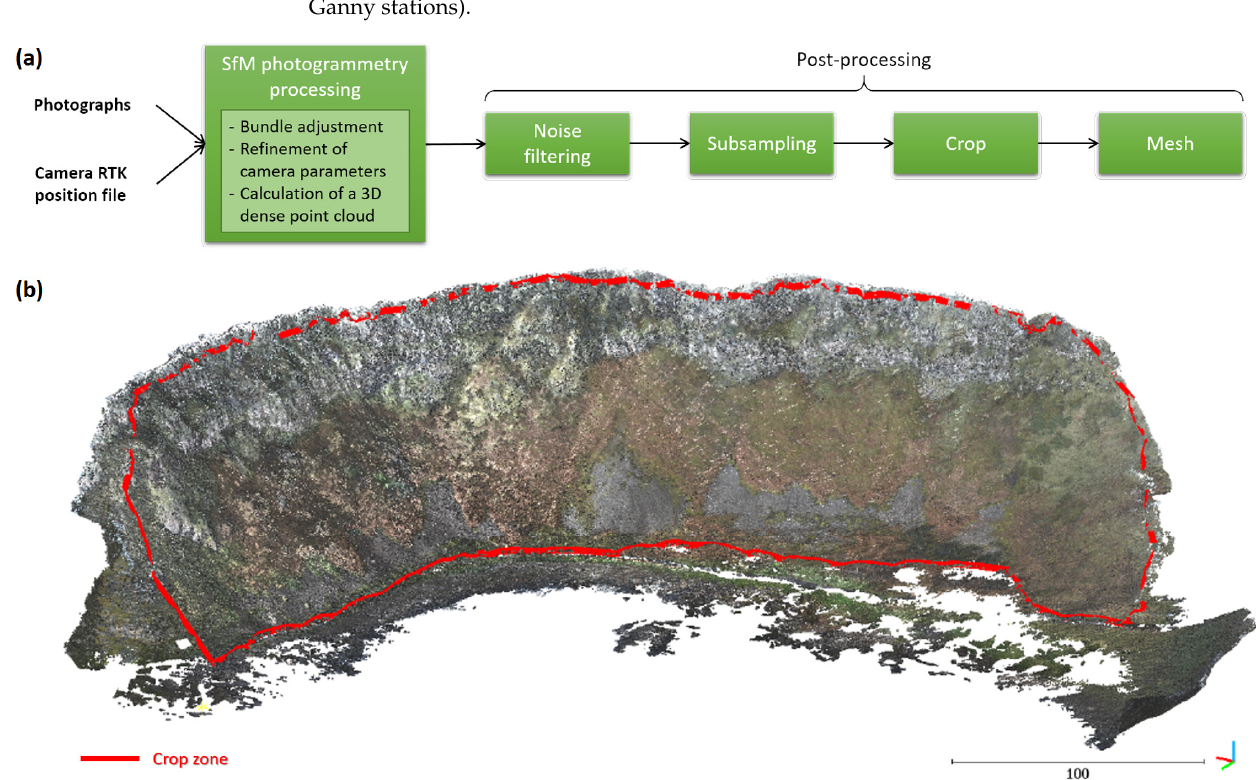
Figure 4. ( a ) Processing chain for the “expert” dataset used as reference. The SfM photogrammetry processing is performed by using Agisoft Metashape , and postprocessing steps are performed by using CloudCompare. ( b ) Resulting 3D mesh before cropping to a common zone for